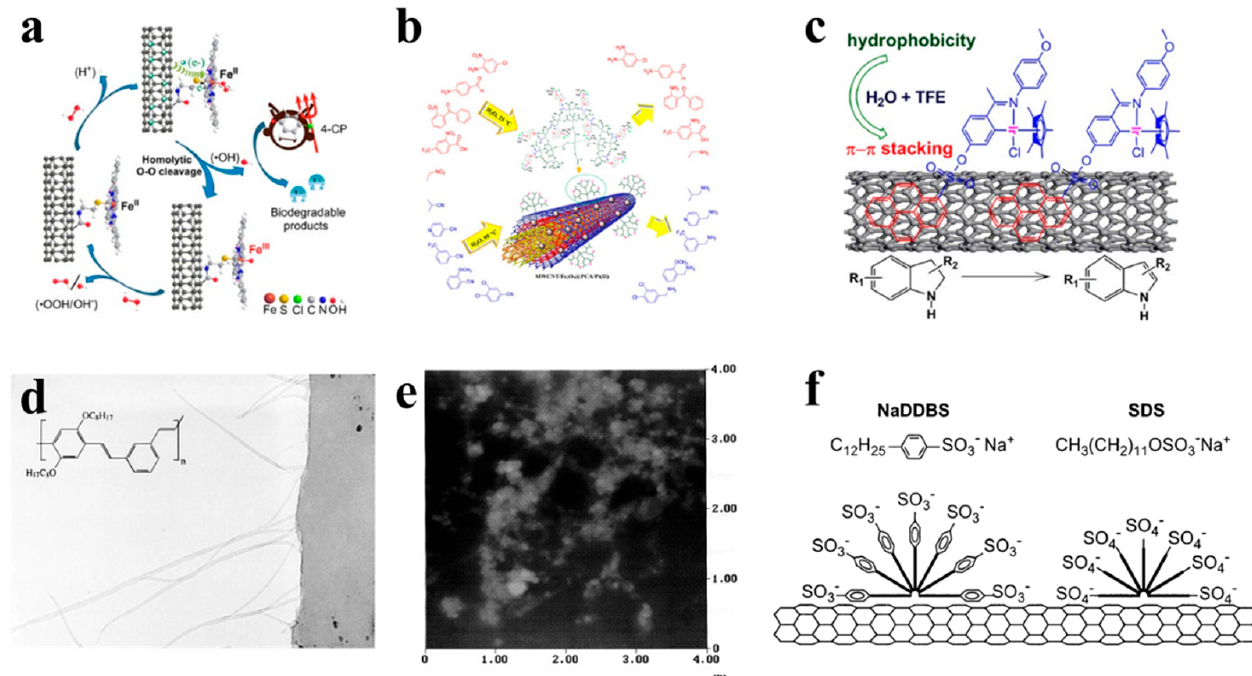
Figure 1. Surface functionalization of carbon nanotubes (CNTs). ( a ) The introduction of the -COOH group to the surface of the CNT [8]. ( b ) The introduction of-COOH on the surface of CNTs by the oxidation reaction [9]. ( c ) A metal iridium complex catalyst was coated on the surface of CNTs through non-covalent bond accumulation [10]. ( d ) TEM image which shows the nominal chemical structure of the polymer backbone [11]. ( e ) The atomic force microscopy image of the waxy corn amylopectin-single-walled CNT (SWCNT) film [12]. ( f ) Schematic representation of surfactants adsorb onto the CNT surfaces [13].